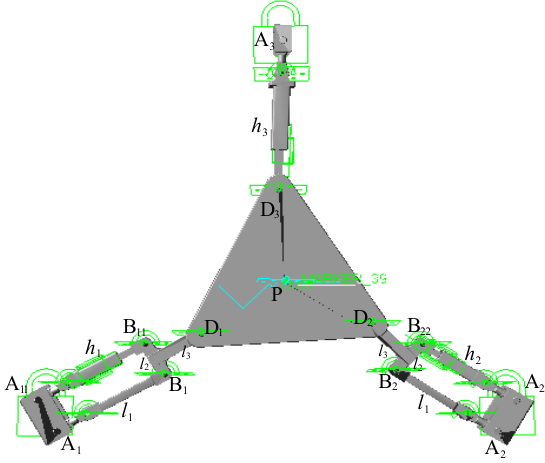
Figure 3. Simulation model of the mechanism in ADAMS. The comparisons between the theory and simulation results of inverse kinematics are shown in Figure 4, and the comparisons between the theory and simulation results of the input velocity of the rods are shown in Figure 5. The solver of the ADAMS software es- tablishes the dynamic equation of the mechanical system through Lagrange's equation of the first kind. The result of its solution is accurate.